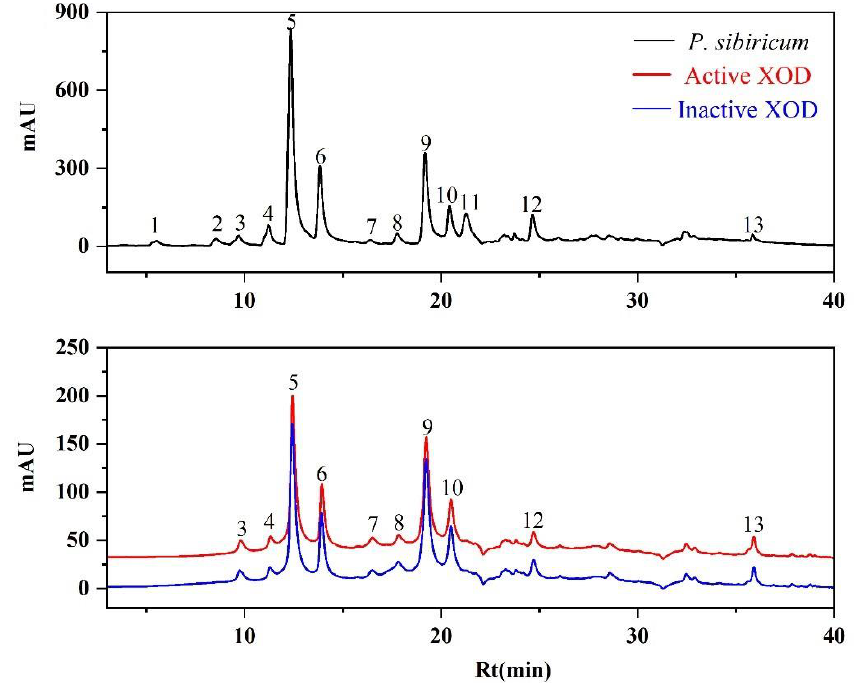
Figure 2. The UF-LC-UV chromatograms of the EA fraction from P. sibiricum with superoxide dis- mutase (SOD) at 280 nm. The black line represents the UPLC profiles of EA fraction, the red and blue line represent activate and inactivate SOD, respectively.